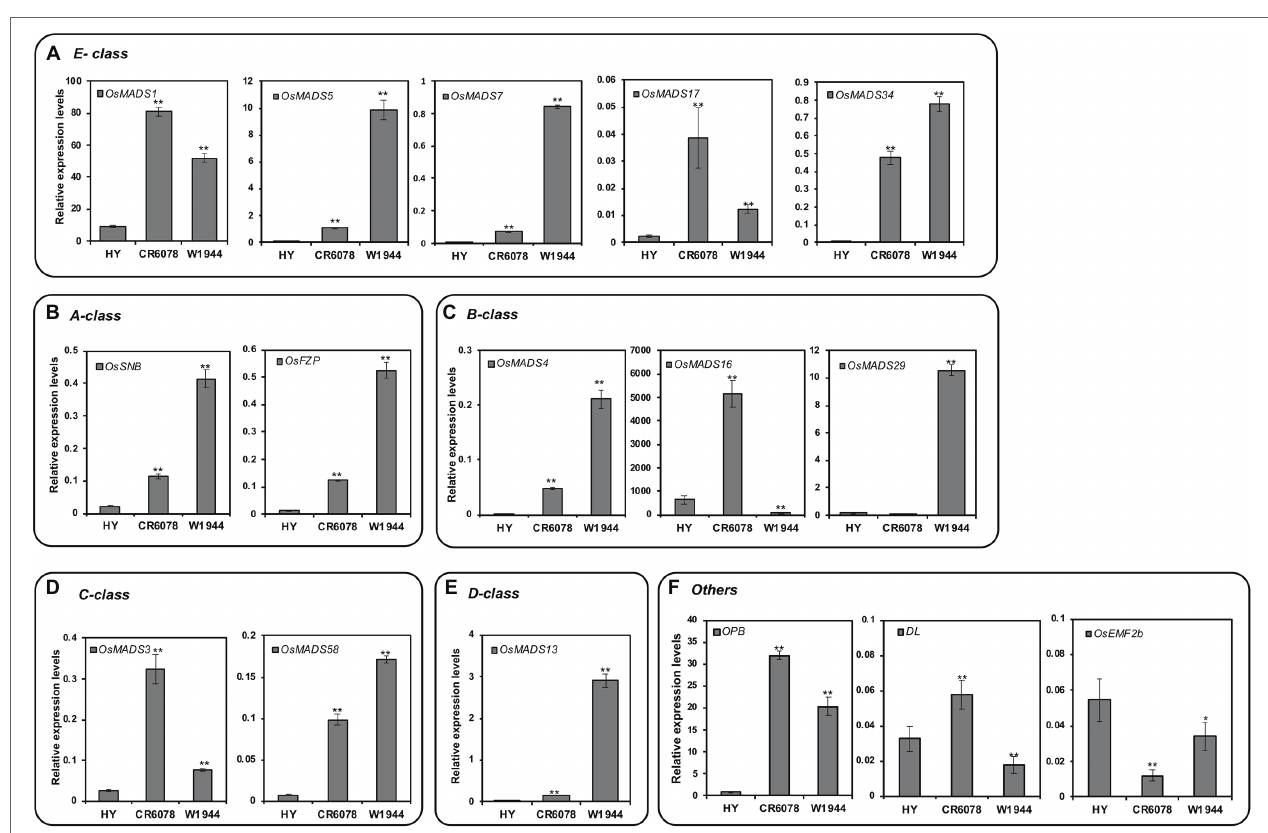
FIGURE 4 | Expression patterns of floral organ determination genes in HY, CR6078, and W1944 plants. (A) E-class, (B) A-class, (C) B-class. (D) C-class, (E) D-class genes, and (F) other genes. Total RNA was isolated from 7-day-old seedlings. Relative expression level of each gene was quantified using real-time PCR and normalized using OsTMP1 as an internal control. The error bars represent mean ± SD ( n = 3). Significant differences between the HY and each OX line, and the CR6078 plants and each RNAi line at * p < 0.05 and ** p <